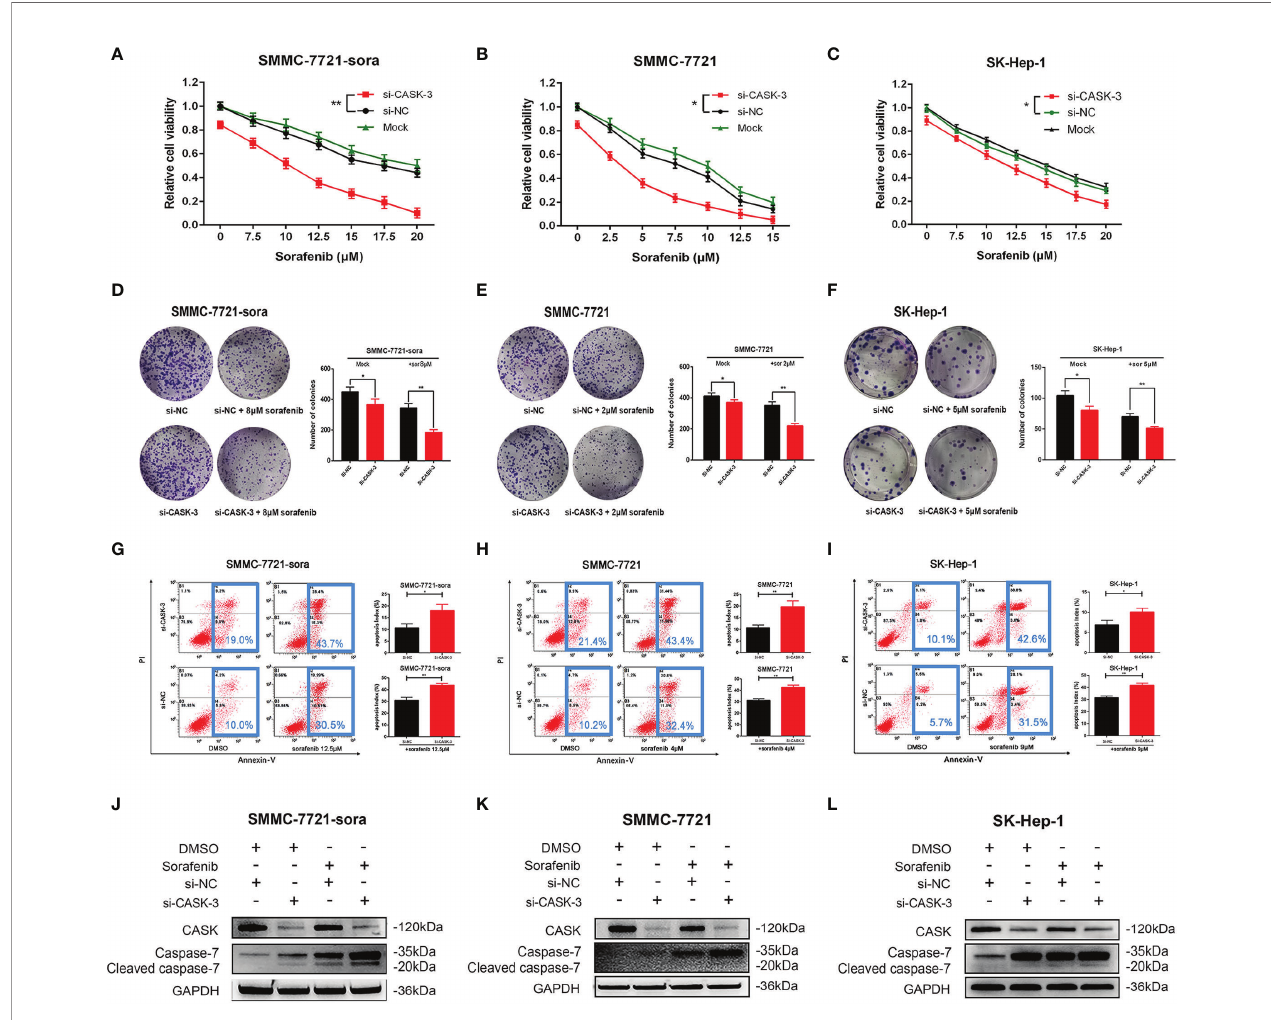
FIGURE 2 | CASK downregulation inhibited HCC cell growth, promoted HCC cell apoptosis and attenuated sorafenib resistance. (A – C) CCK-8 assay analysis of the impact of CASK knockdown combines with various concentrations of sorafenib on SMMC-7721-sora, SMMC-7721 and SK-Hep-1 cells growth. (D – F) Colony information assay showing the effects of CASK knockdown on SMMC-7721-sora, SMMC-7721 and SK-Hep-1 cells growth with or without sorafenib treated. (G – I) The apoptosis rate in CASK knockdown or control cells with or without sorafenib treated was measured by fl ow cytometry analysis. (J – L) Western blotting analysis of apoptosis-related protein levels in CASK knockdown or control cells, with or without sorafenib treated (sorafenib treated concentration: SMMC-7721: 10 m M, SMMC-7721-sora: 20 m M, SK-Hep-1: 15 m M; treated time: 72 h). *P < 0.05, **P <